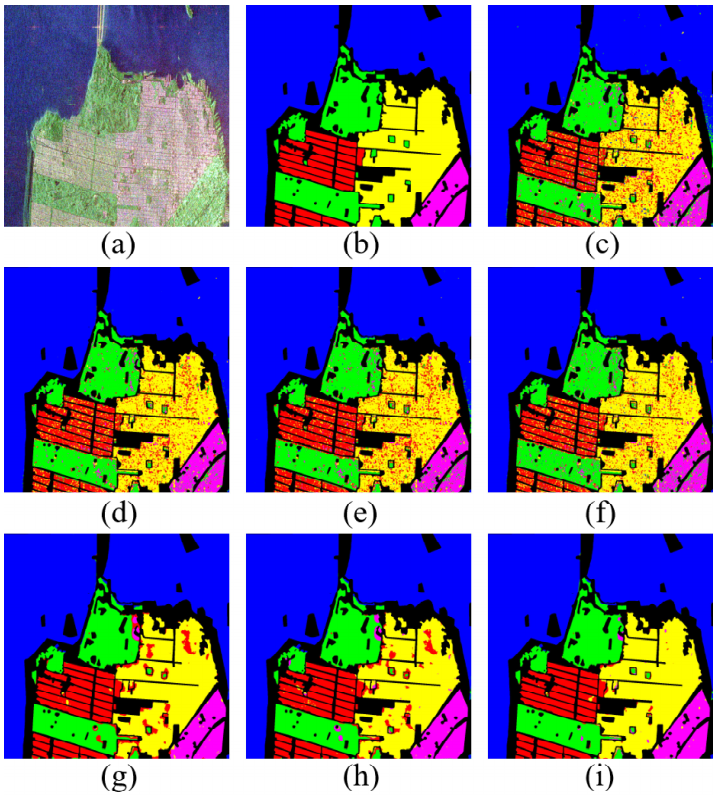
Figure 11. Results of the San Francisco dataset: ( a ) pseudocolor image; ( b ) ground truth; ( c ) CNN;